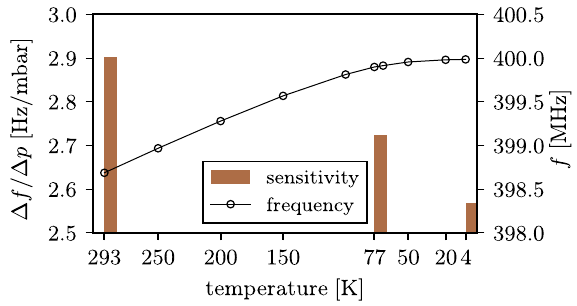
FIG. 20. In brown, the frequency versus pressure sensitivity at different temperatures as simulated in APDL . In black, the corresponding fundamental mode frequency without quasistatic pressure. To mimic the setup of a vertical cold test in a cryostat, the cavity is fixed only at the top flange such that gravity is applied in longitudinal direction.